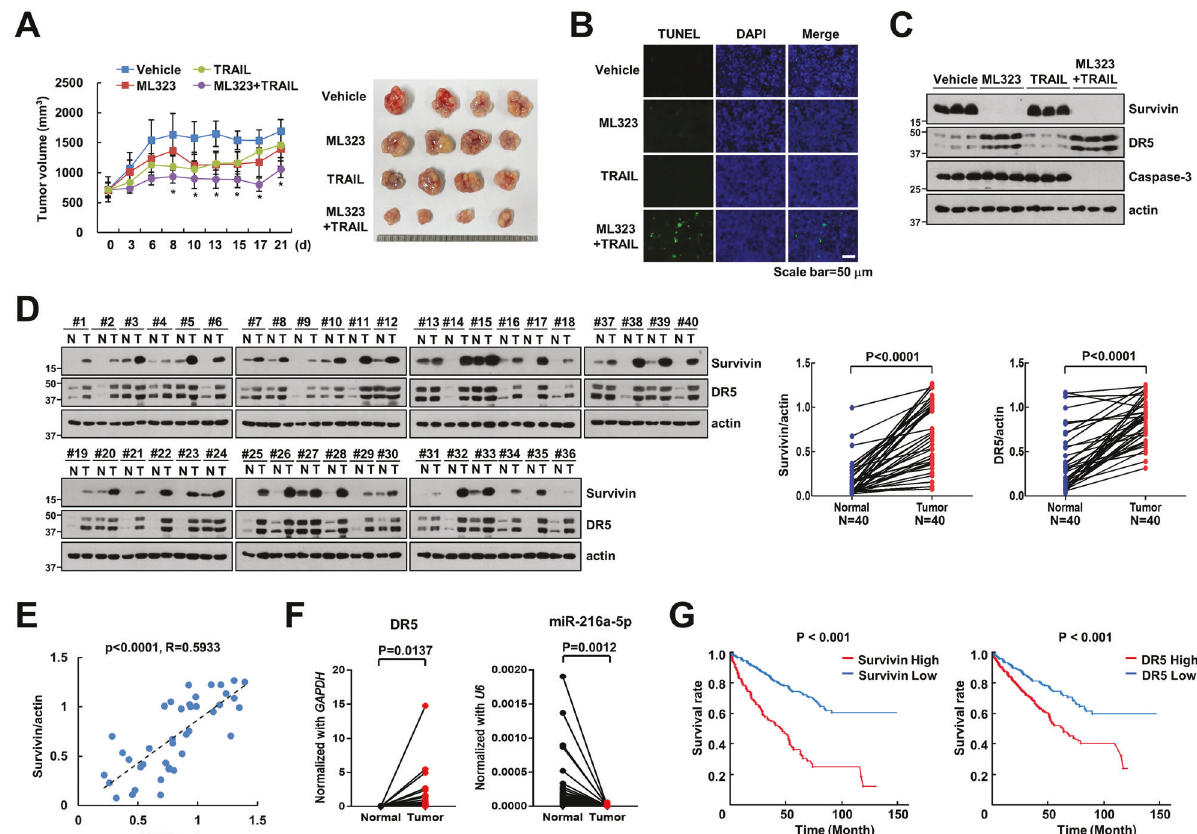
Fig. 8 Anti-tumor effect of combination of ML323 and TRAIL in xenograft model. A – C Mice bearing HCT116 cells were treated with 10 mg/ kg ML323, 3 mg/kg GST-TRAIL, combinations, or vehicle (i.p.) for 21 days. Tumor volume and size were measured ( A ). Terminal deoxynucleotidyl transferase (TdT) dUTP Nick-End Labeling (TUNEL) assays were performed to check apoptosis in vivo. scale bar: 50 μ m ( B ). Protein expression was measured by western blot analysis ( C ). D Examination of survivin and DR5 protein expression in 40 paired primary RCC tissues and corresponding normal adjacent tissues. E Correlation analysis of protein expression of USP1/survivin. F Examination of DR5 ( left panel ) and miR-216a-5p ( right panel ) mRNA expression in 40 paired primary renal cancer cell (RCC) tissues and corresponding normal adjacent tissues. G Analysis of prognostic signi fi cance of survivin and DR5 in RCC patients based on TCGA. * P < 0.01 compared to the vehicle. i.p. intraperitoneal